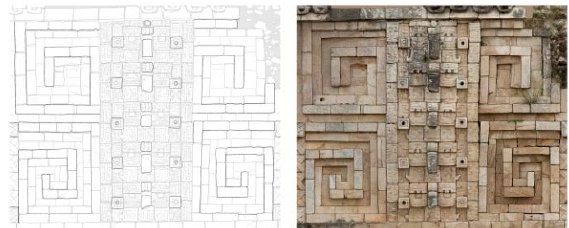
Figure 17. Architectonic and photogrammetric restitution of the Palace of the Governor’s frieze. Detail. (Project MAYATECH 2019).